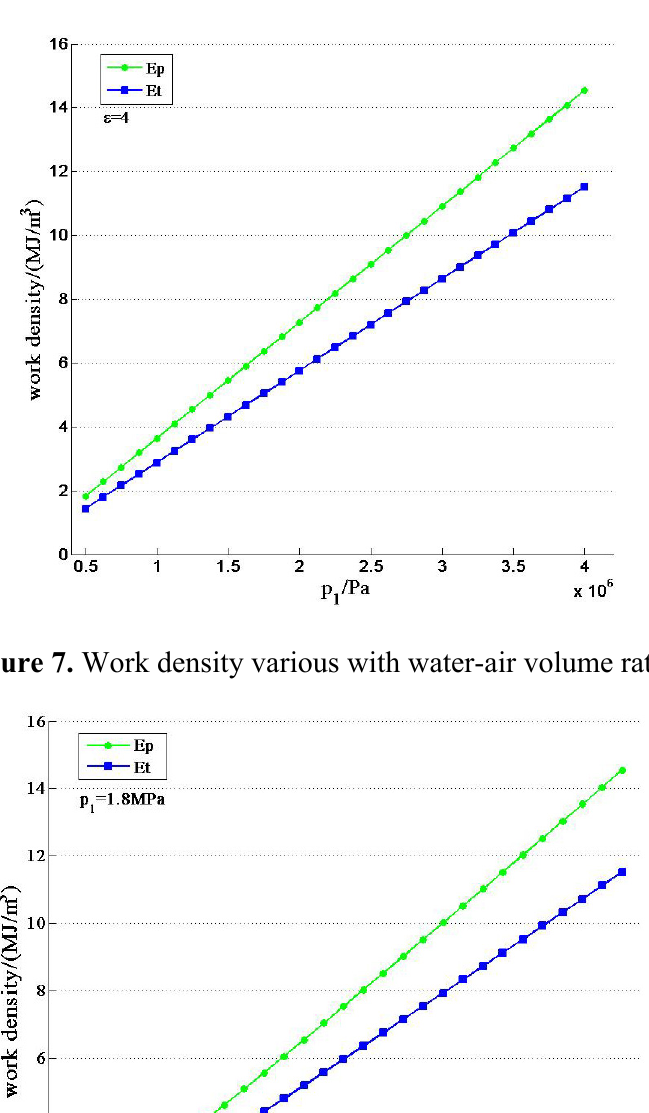
Figure 6. Work density various with pre-set pressure.